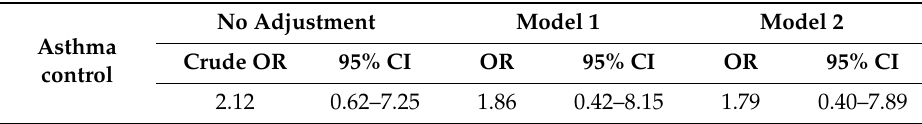
Table 2. Odds ratio for improved asthma control in participants assigned to the “low”, compared the “high”, cotinine category.